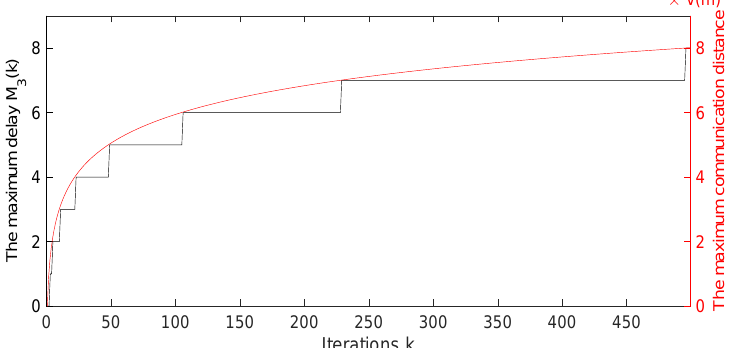
( 3 ) ( k ) between agents and the maximum delays max